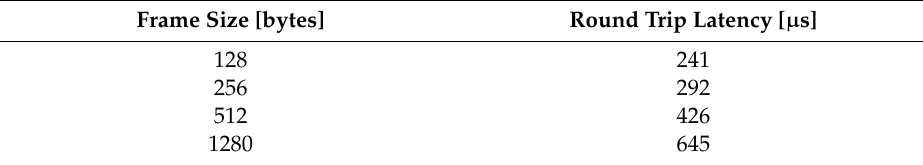
Figure 9. The interval time in microseconds between packets of CMC—Simulator, an IED. Table 4. Time display and time